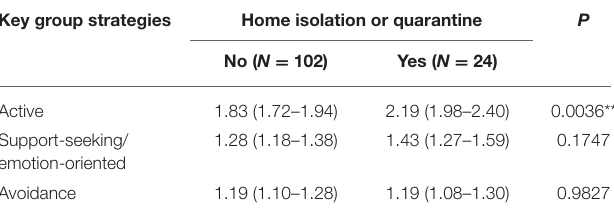
TABLE 5 | Key groups of coping strategies among nurses in Belarus who have undergone home isolation or quarantine. Key group strategies